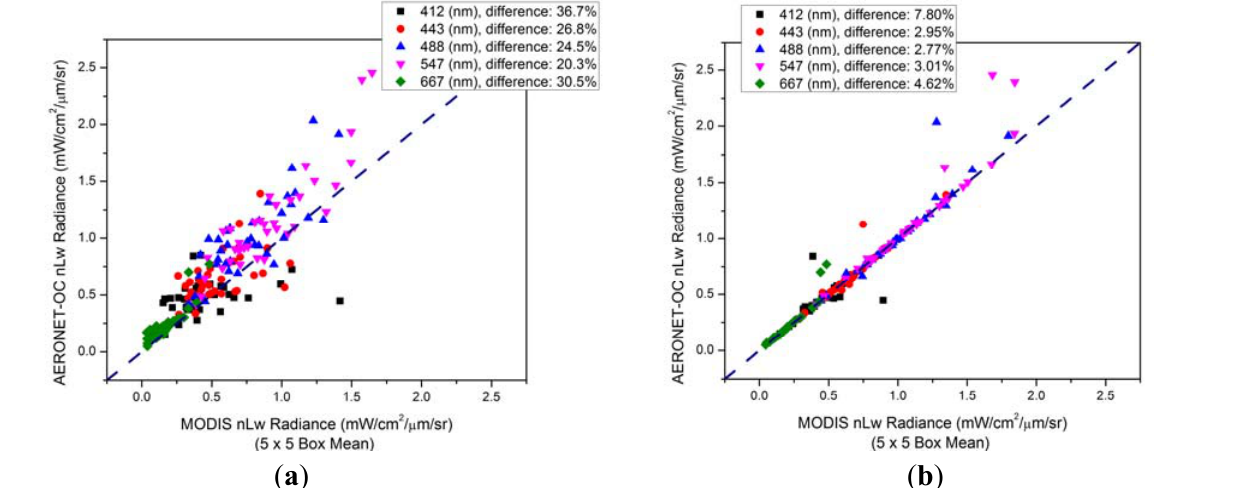
L at 412, 443, 488, 547, and 667 wavelengths for Martha’s Vineyard, n w